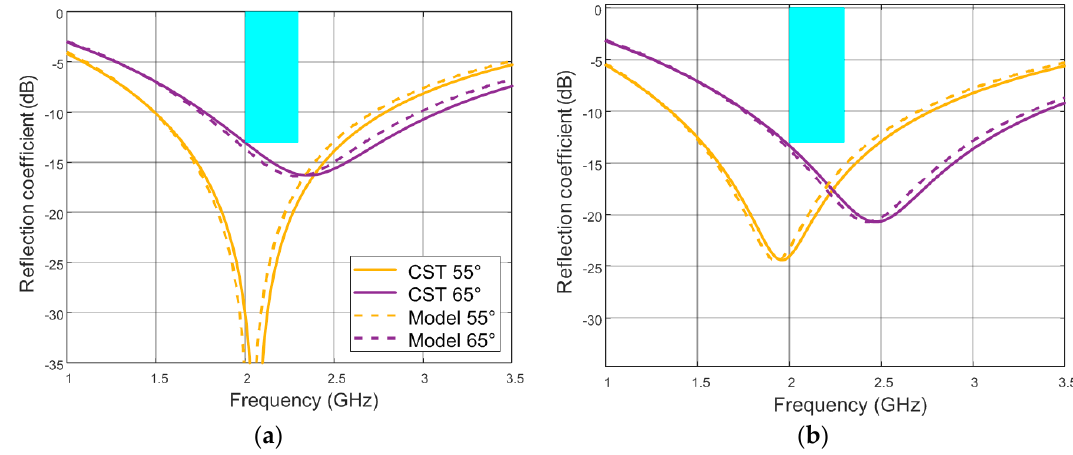
Figure 5. Comparison between analytical model and EM simulation of sectorial absorber B for TE polarization ( a ) and TM polarization ( b ).